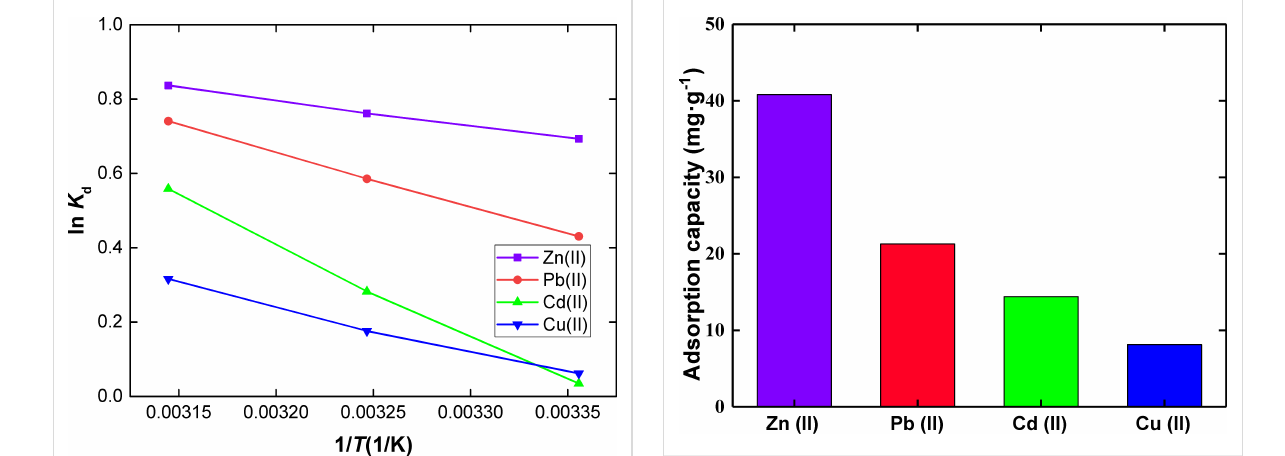
Figure 11: Effect of metal ions on the extraction of Zn(II) with SiNL. (shaking time: 25 min, pH 6, T = 25 °C. Adsorption dose: V = 10 mL, m = 10 mg of SiNL at optimum concentrations: 100 ppm of each studied metal, Pb(II), Cu(II), Zn(II), and Cd(II).